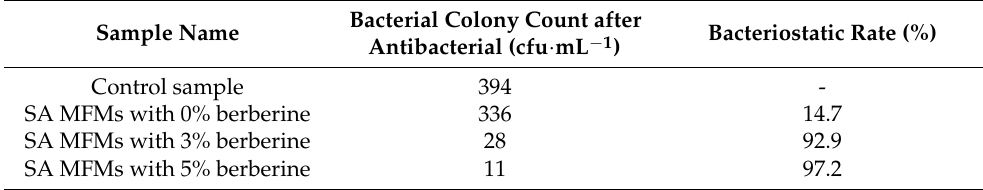
Table 3. Bacteriostatic rates of SA/PVA/PEO 5:3:2 MFMs containing different mass fractions of berberine.